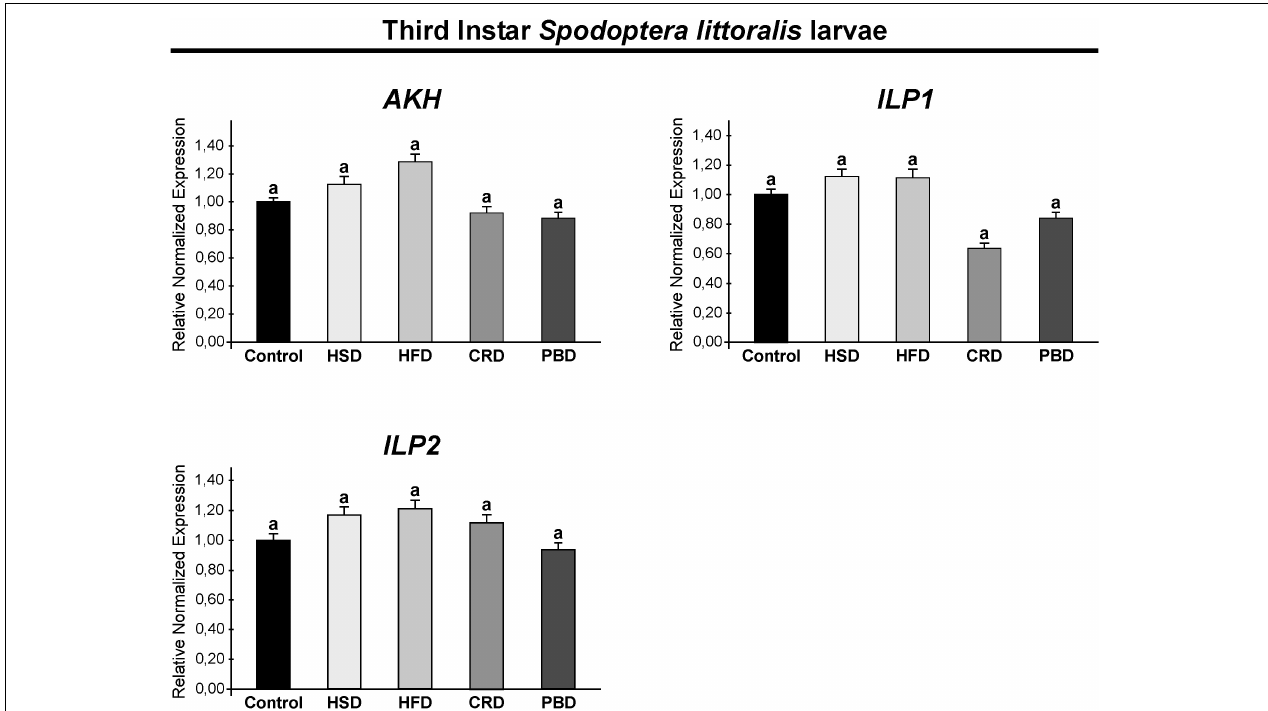
FIGURE 5 | Effects of different diet treatments on the expression of Spodoptera littoralis adipokinetic hormone ( SpoliAKH ), insulin-like peptide 1 ( SpoliILP1 ), and insulin-like peptide 2 ( SpoliILP2 ) at third instar larvae by Real-time PCR. Spodoptera littoralis actin gene was used as the internal reference. The statistical significance of transcript abundance differences among groups was determined through ANOVA, followed by the Tukey HSD test (groups associated with different letters are significantly different from each other, p < 0.05). Values are expressed as means ± standard error. Control, Regular artificial bean diet; HSD, High sugar diet; HFD, High fat diet; CRD, Calcium-rich diet; PBD, Plant-based diet.